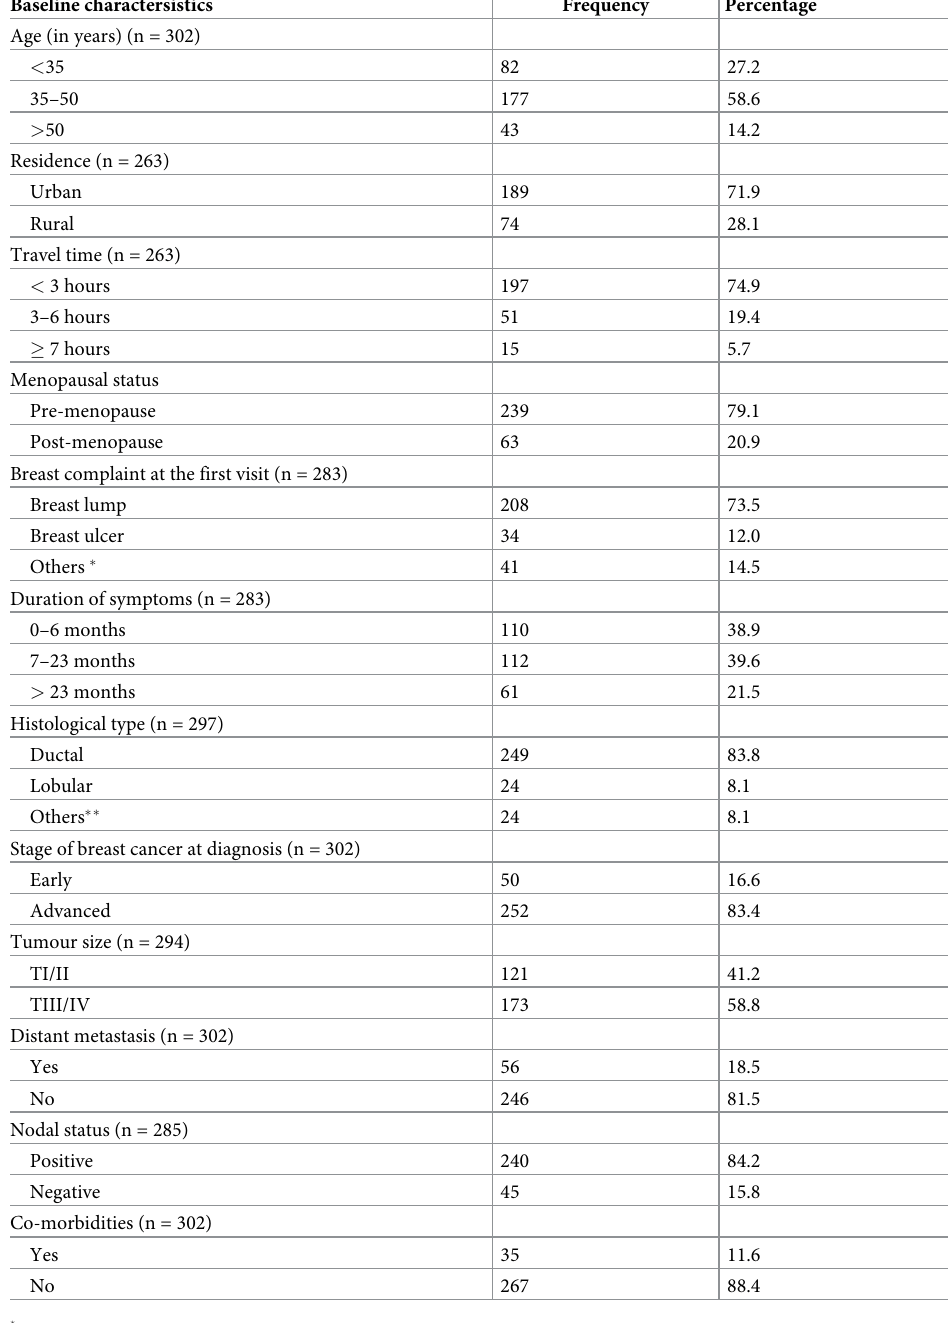
Table 1. Baseline characteristics of female breast cancer patients in southern Ethiopia, 2013–2018 (n =